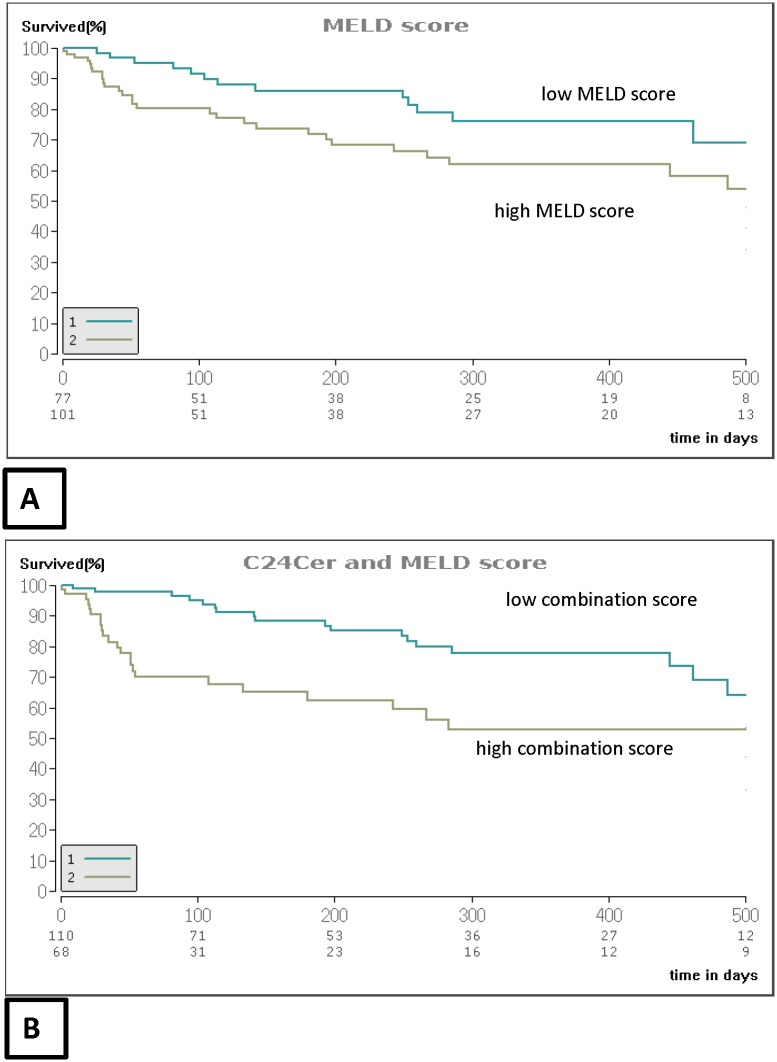
Overall survival in patients with decompensated cirrhosis after stratification to C24Cer and MELD.Cumulative survival is significantly diminished in patients with low C24Cer (≤ 391 ng/ml) and high MELD score (≥15) (p<0.001). As a reference the cumulative survival of patients according to the MELD score is illustrated as well (p<0.001). Cumulative survival was calculated with the univariate Cox regression model. MELD: model of end stage liver disease, Cer: ceramide.